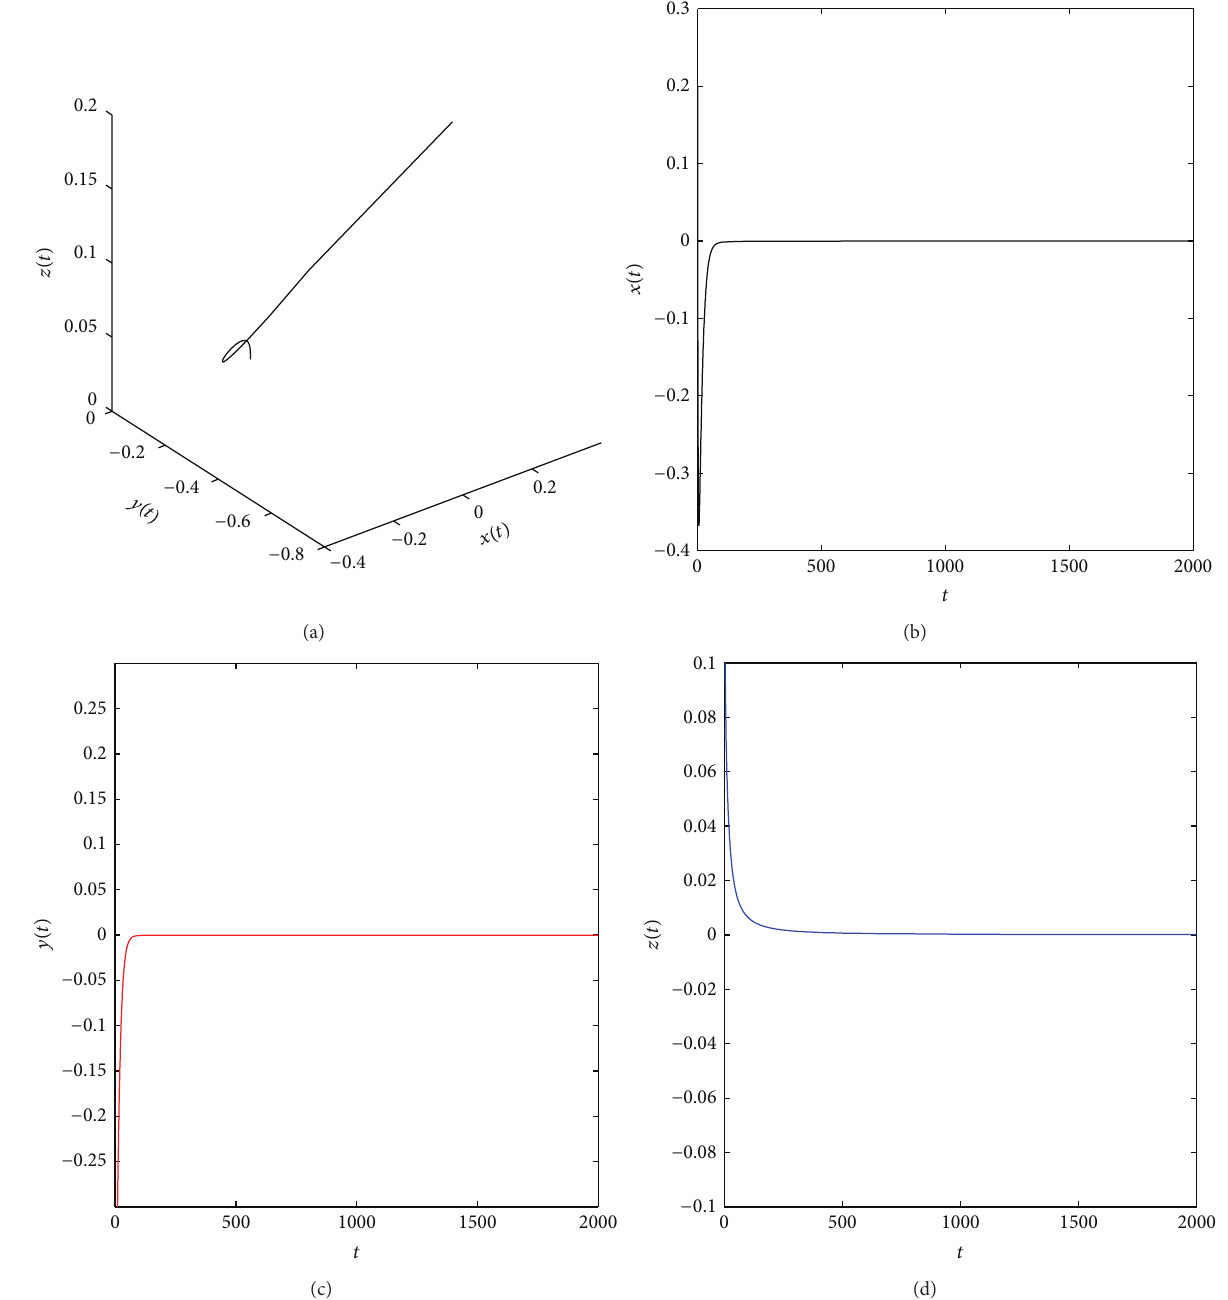
Figure 7: The equilibrium point ̂𝑥 1 of the distributed order fractional Chen system (22) with ( 𝑞 11 , 𝑞 12 , 𝑞 21 , 𝑞 22 , 𝑞 31 , 𝑞 32 ) = (0.25, 0.85, 0.25, 0.95, 0.25, 0.75) and (𝑎,𝑏, 𝑐) = (50, 3, 20) is asymptotically